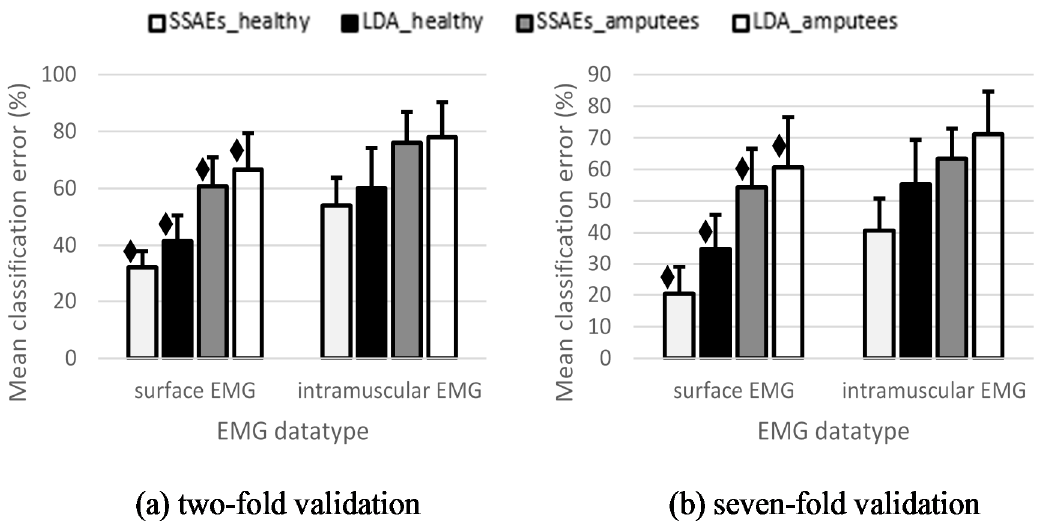
Figure 8. ( a ) Two-fold and ( b ) seven-fold validation. Mean (and SD) classification error obtained with two different classifiers for both kinds data of healthy and amputee subjects. The diamond symbol indicates the best EMG data type, with statistical significance ( p < 0.01).